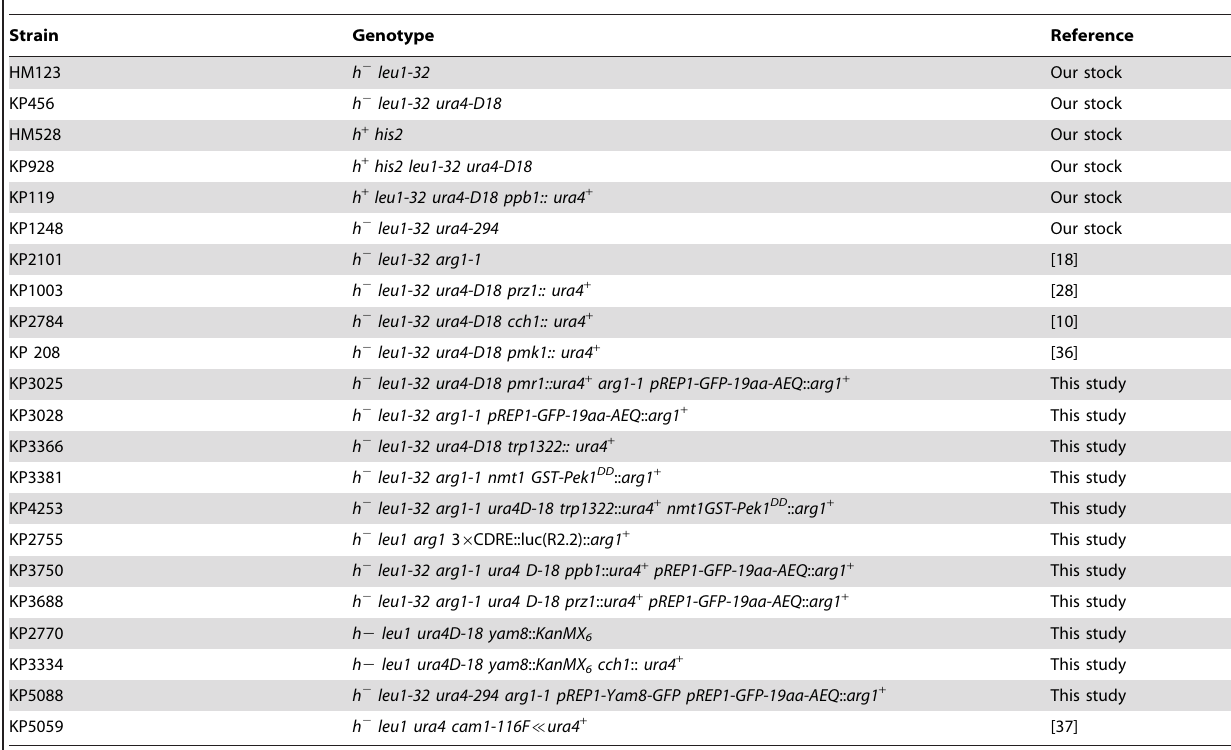
Table 1. Strains used in this